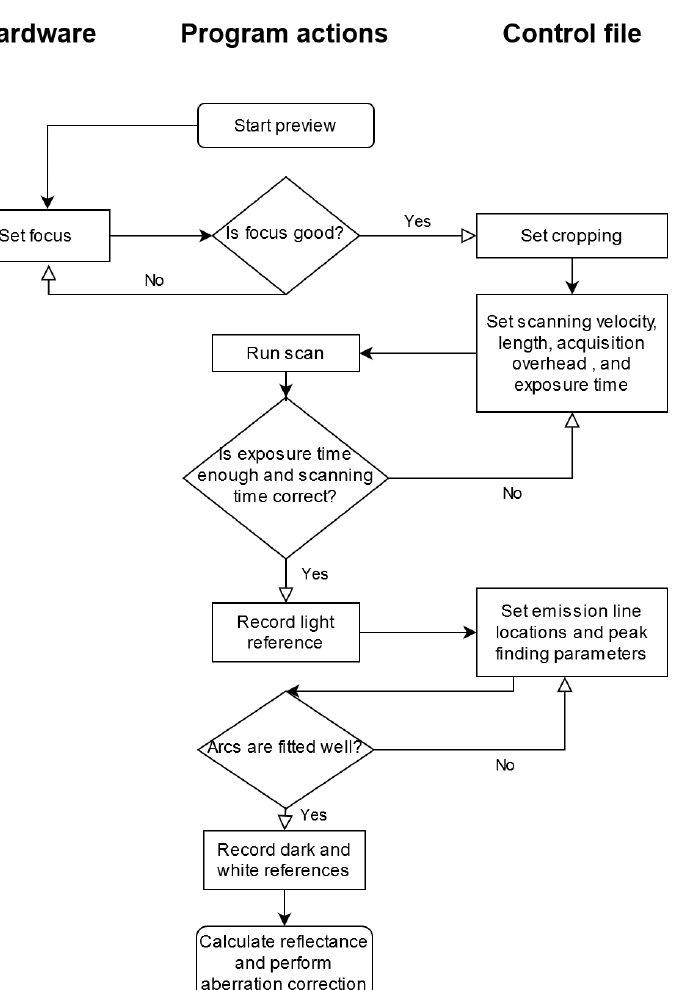
Figure 3. Flowchart of proposed imaging and aberration correction process. Hardware operations are located in the left-hand column, the center column holds software actions and the rightmost column represents settings written to the control